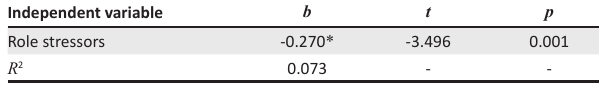
TABLE 4: Regression analysis of role stress on job